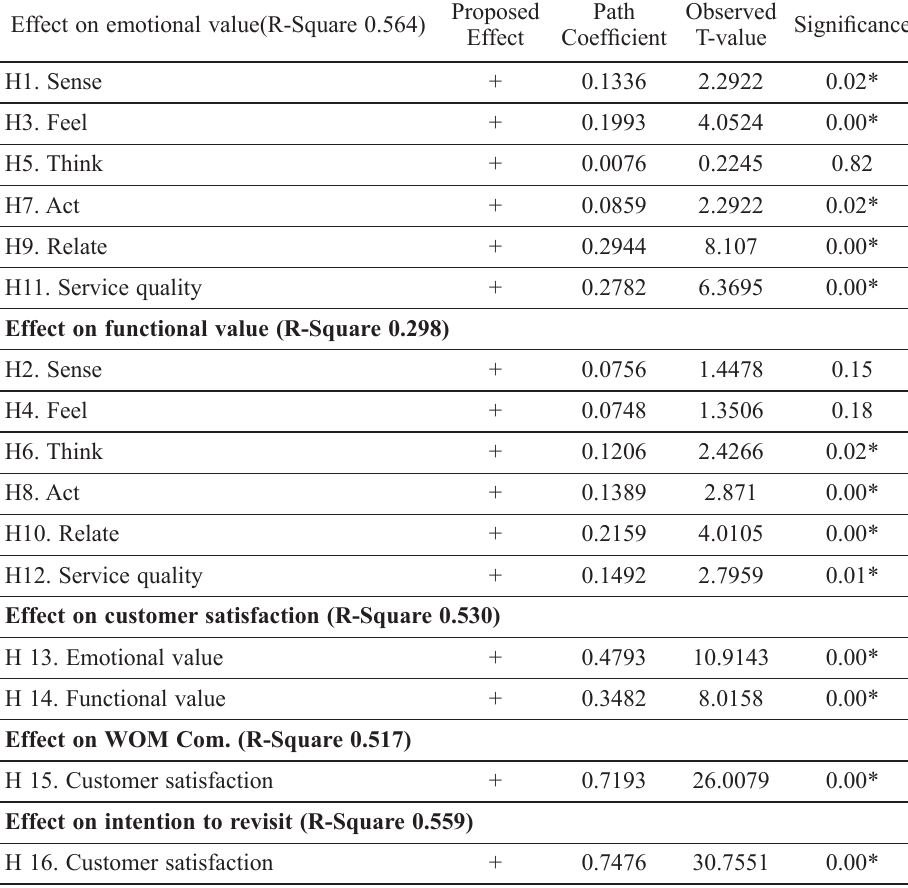
Table 3. Structural model